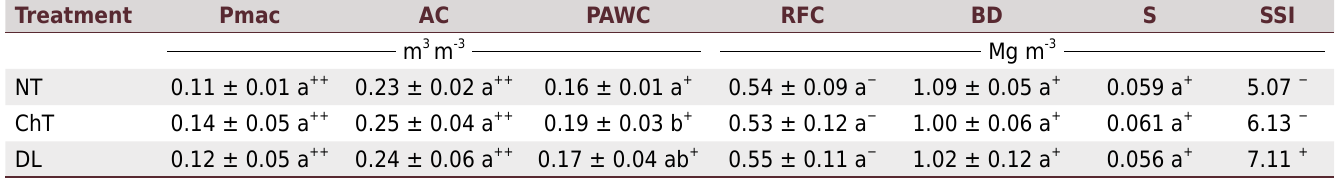
Table 2. Mean values and standard deviations of macroporosity (Pmac), air capacity (AC), plant available water capacity (PAWC), relative field capacity (RFC), bulk density (BD), Dexter´s index (S), and structural stability index (SSI) for the different